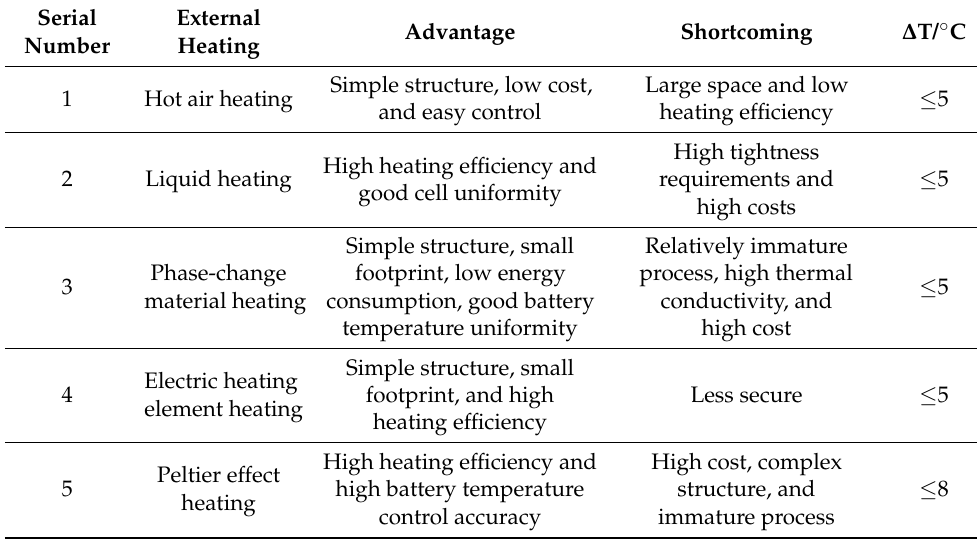
Table 3. Features of five external heating systems.